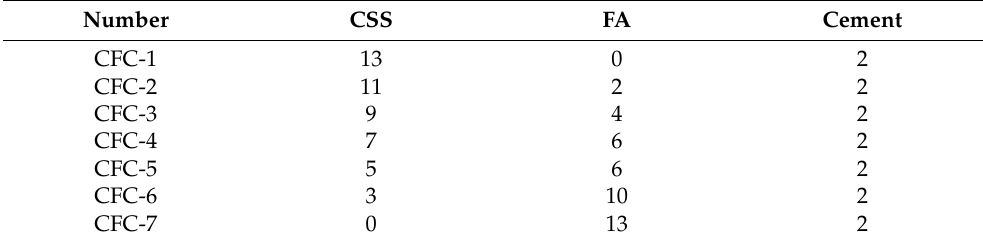
Table 2. Test scheme of calcium silicate slag pavement base material